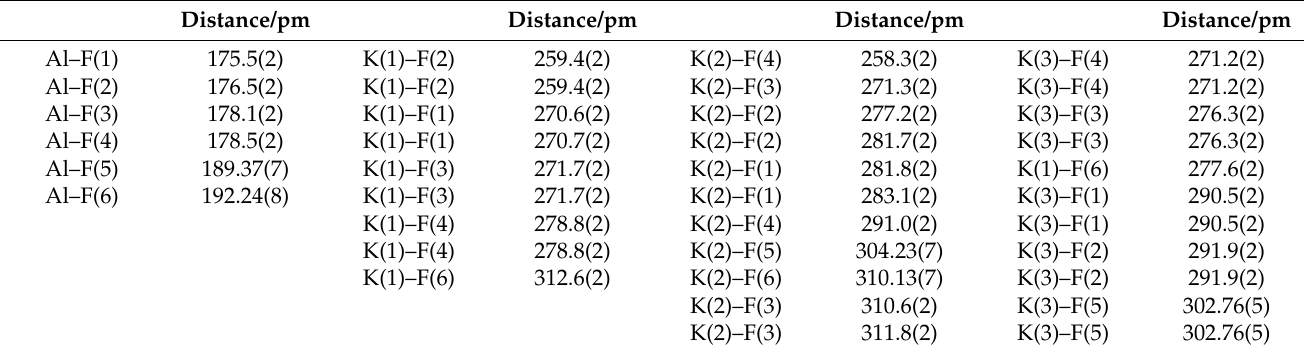
Figure 3. Interconnection of the infinite fluoridoaluminate zig-zag chains by potassium ions in K 2 AlF 5 -2.